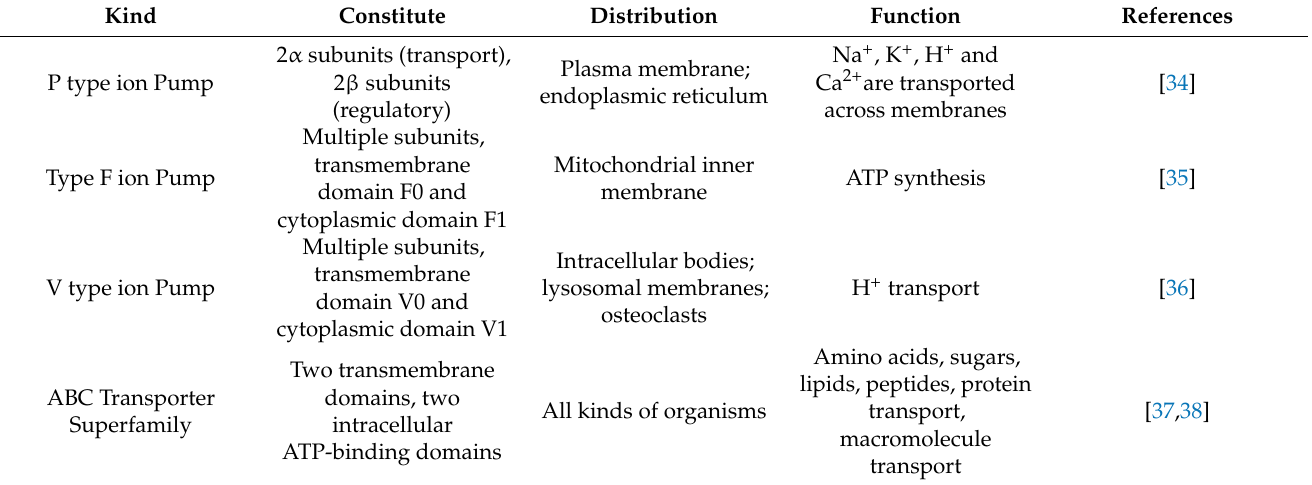
Table 3. ATP-driven pump